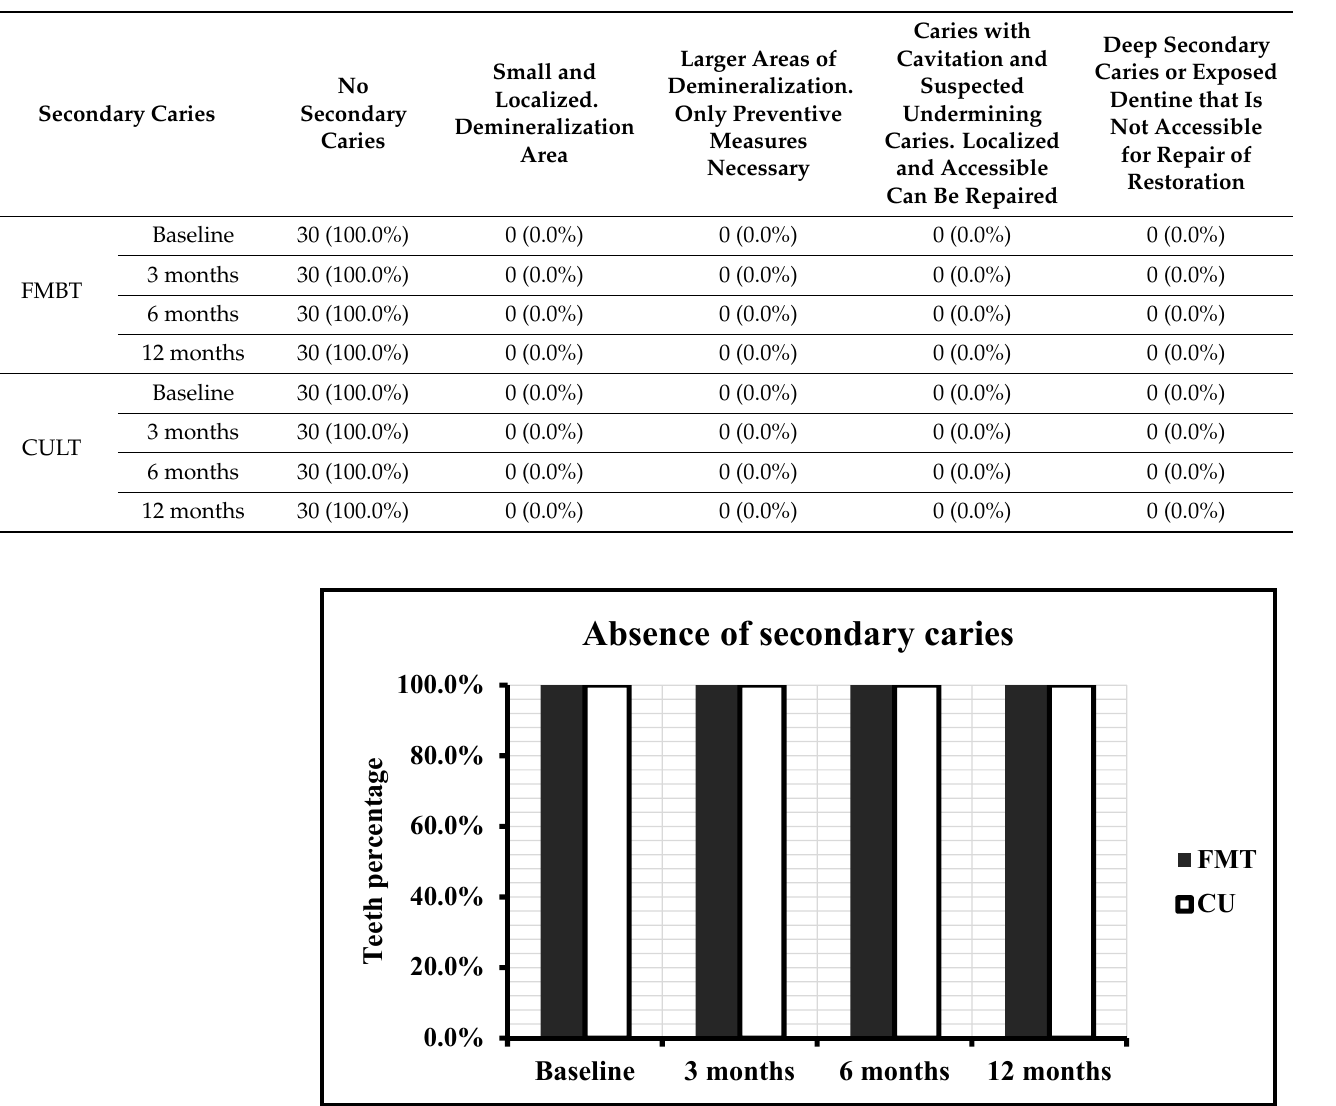
Table 4. Assessment of secondary caries for teeth restored with FMBT and CULT over time ( p > 0.05).